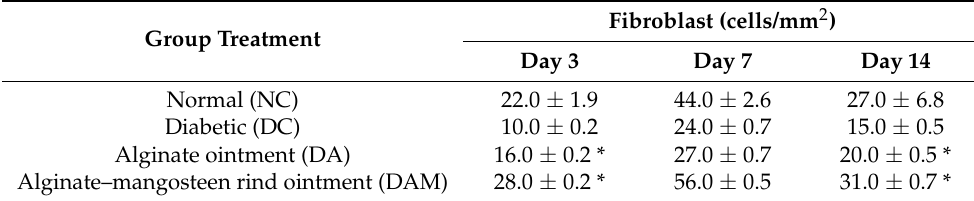
Table 7. Cell counts considering the mean and standard deviation of fibroblasts.